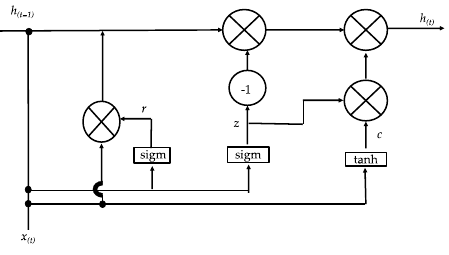
Figure 5. Architecture of the GRU cell.